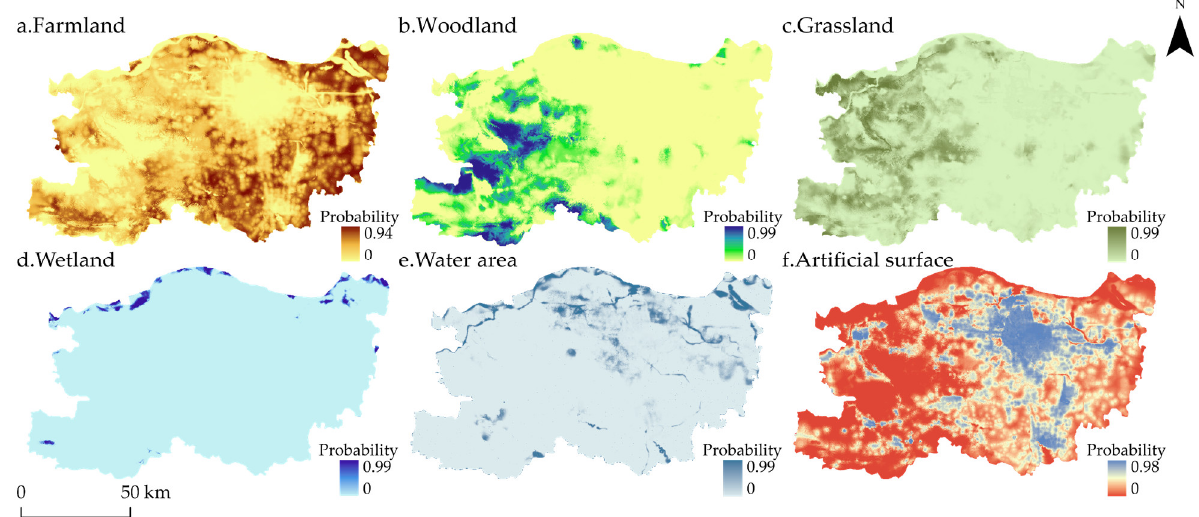
Figure 3. Land development